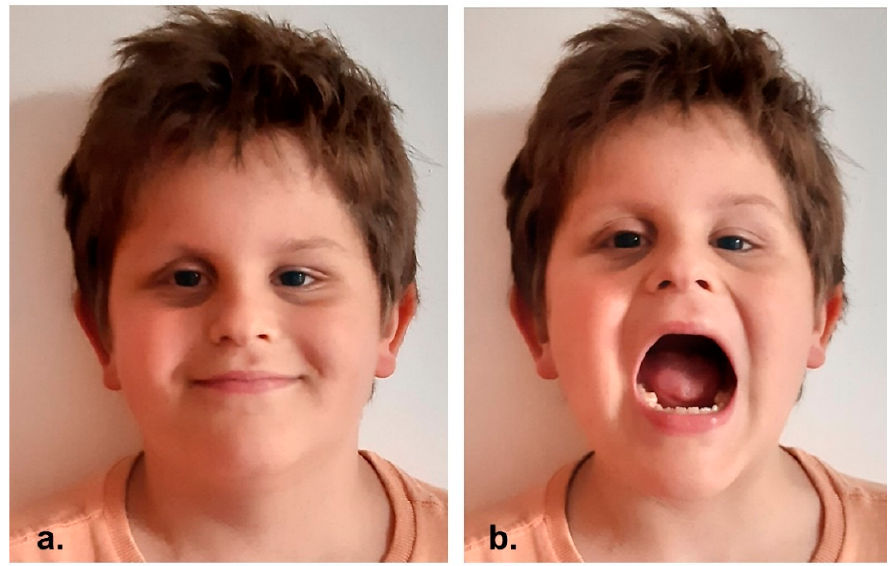
Figure 5. ( a , b ) Clinical appearance at 6-years follow-up.